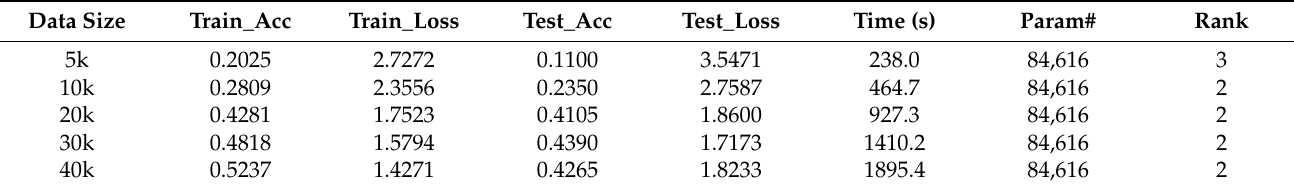
Table 7. Specific parameters and experimental results of the LSTM model. Data Size